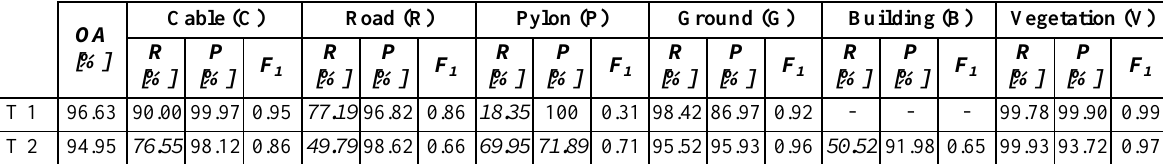
Table 1. Overall accuracy (OA, in %), recall (R, in %), precision (P, in %) and F1-score values achieved in the two tests (the symbol “-“ indicates that the class “Building” is missing in MT 1). Values in italic indicate the main issues, to be addressed in the